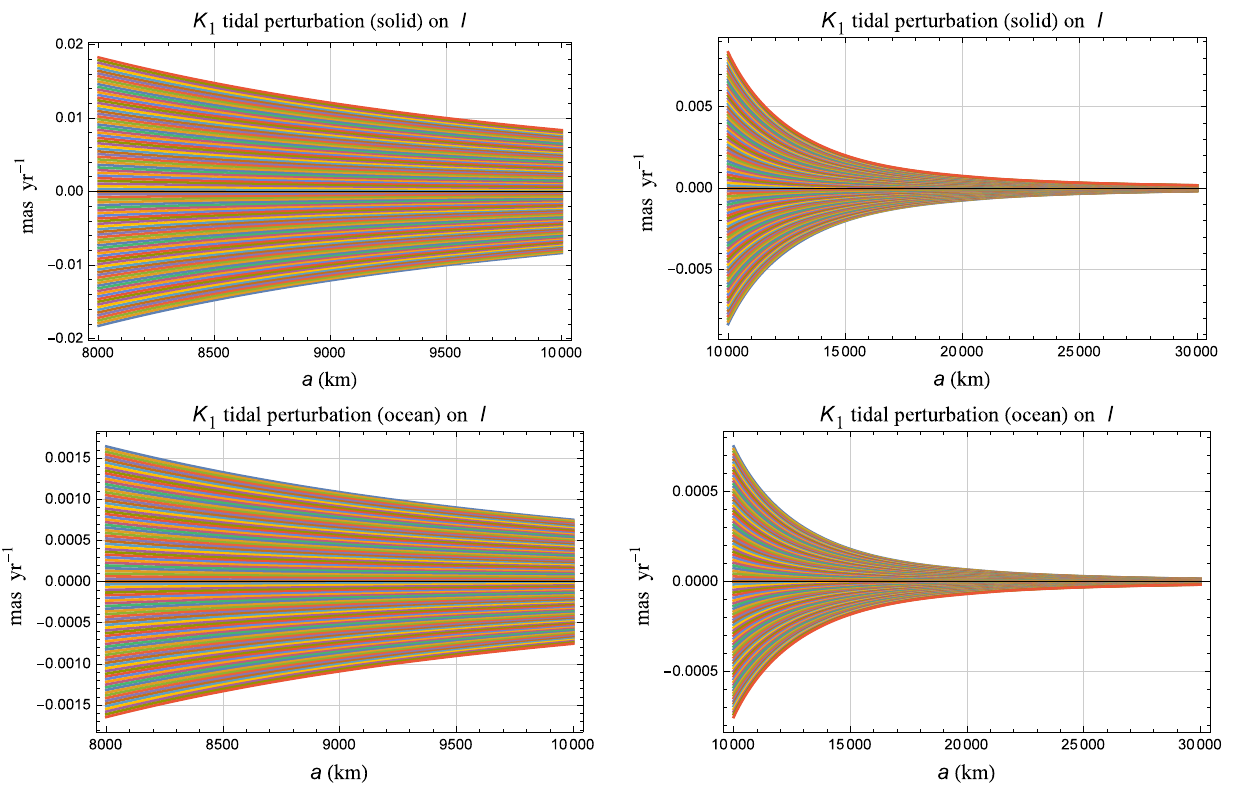
Fig. 2 Nominal amplitudes, in mas year − 1 , of the rates of change of the satellite’s inclination I induced by the solid (upper row) and ocean prograde (lower row) components of the K 1 tide for (cid:5) = 2 , m = 1 , p = 1 , q = 0 from Eqs. (17) to (18) as a function of the semimajor axis a for different values of I in the same range I = 90 ± 5 × 10 − 5